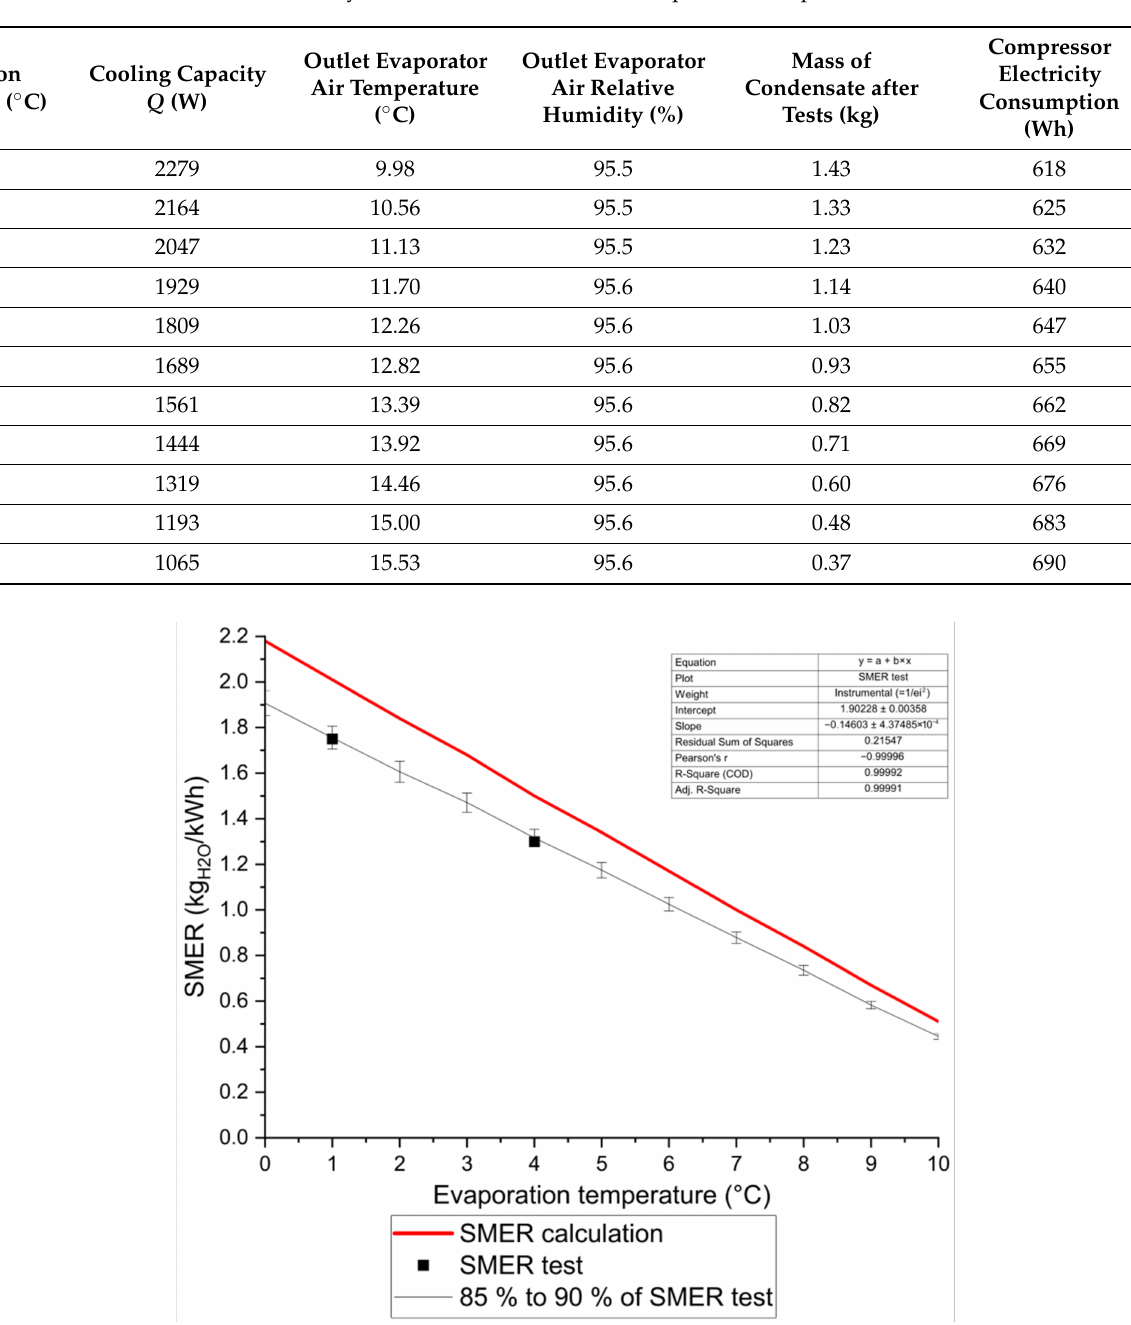
Table 7. Summary of calculations for different evaporation temperature.